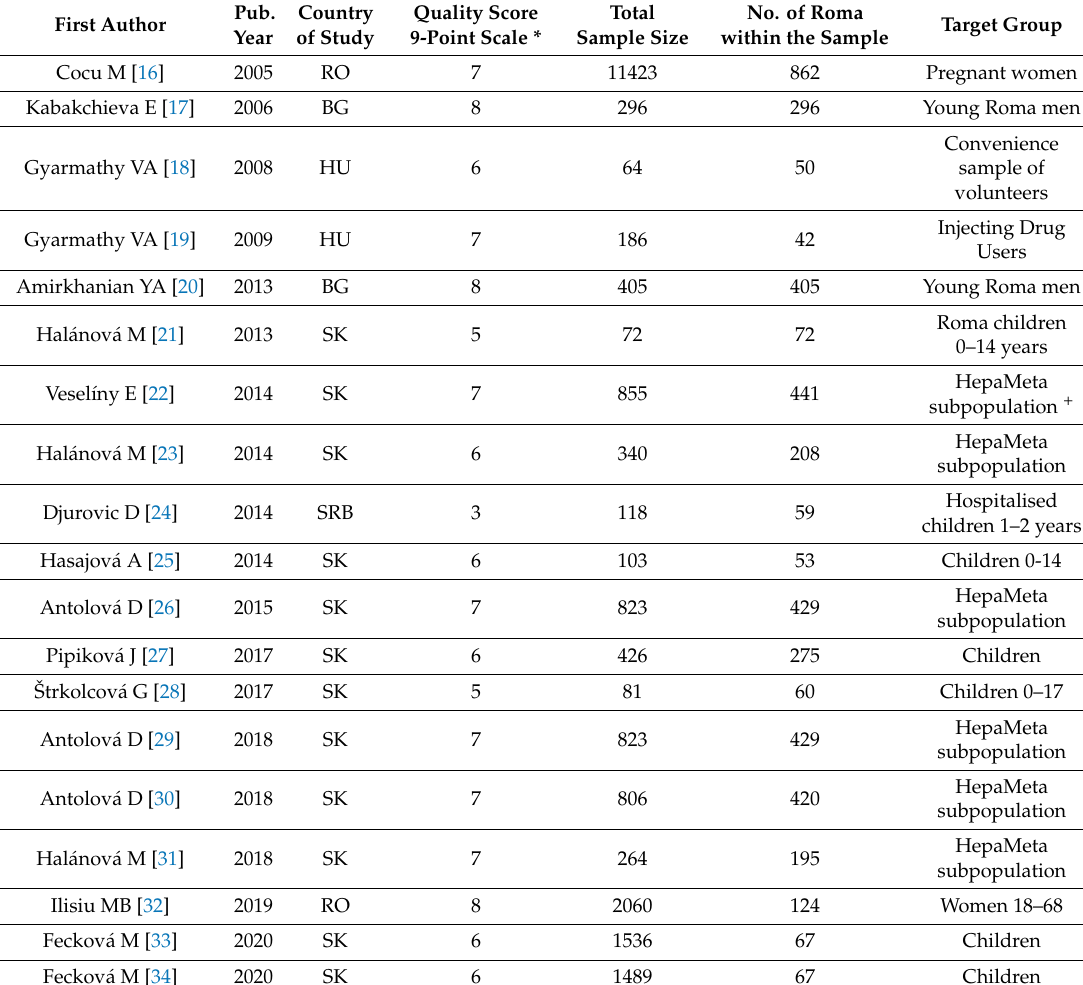
Table 1. Papers selected for